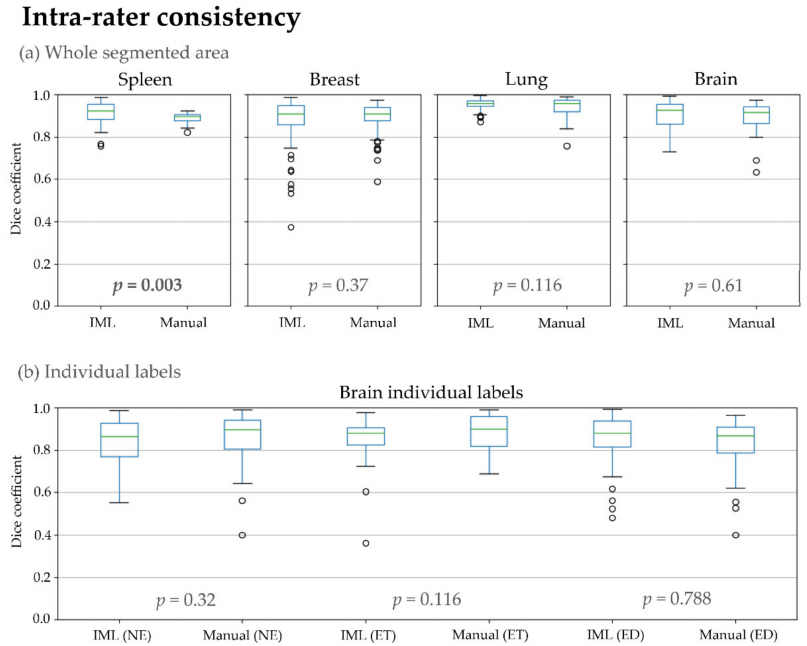
Figure 6. Dice coefficient between the first and second round of the raters where: ( a ) All individual la- bels representing different areas of the structure counted as one; ( b ) Individual areas of glioblastomas.